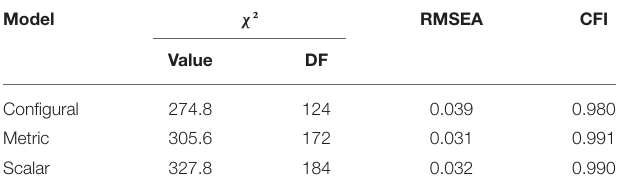
TABLE 4 | χ ² -test and fit indices for invariance testing (short form).